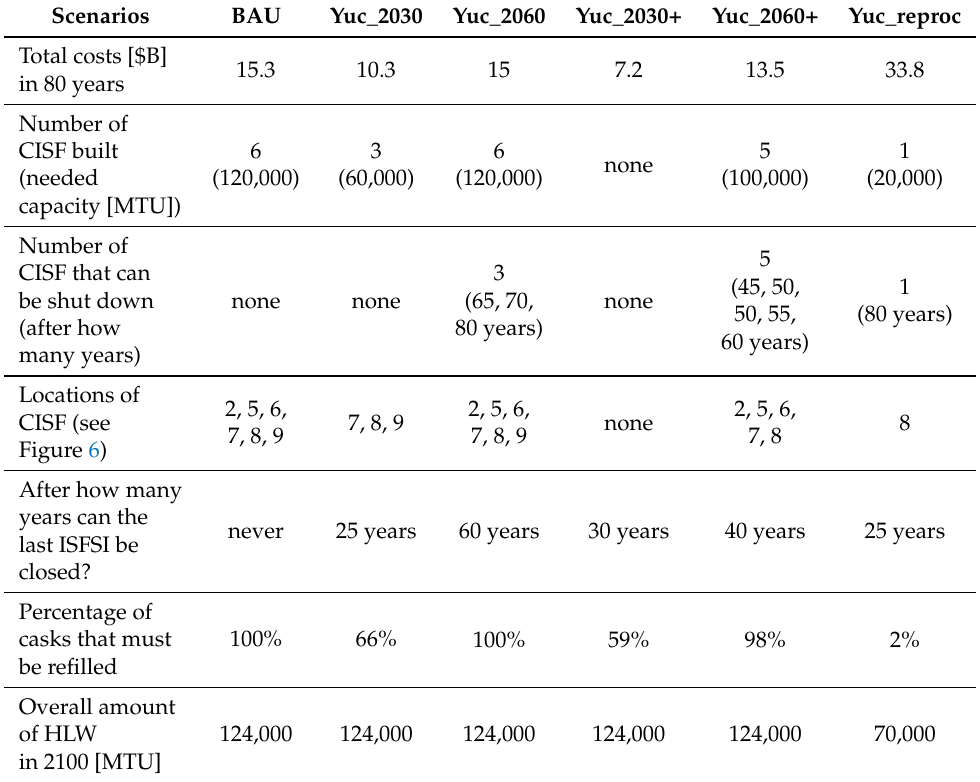
Table 3. Overview of the results of all scenarios.